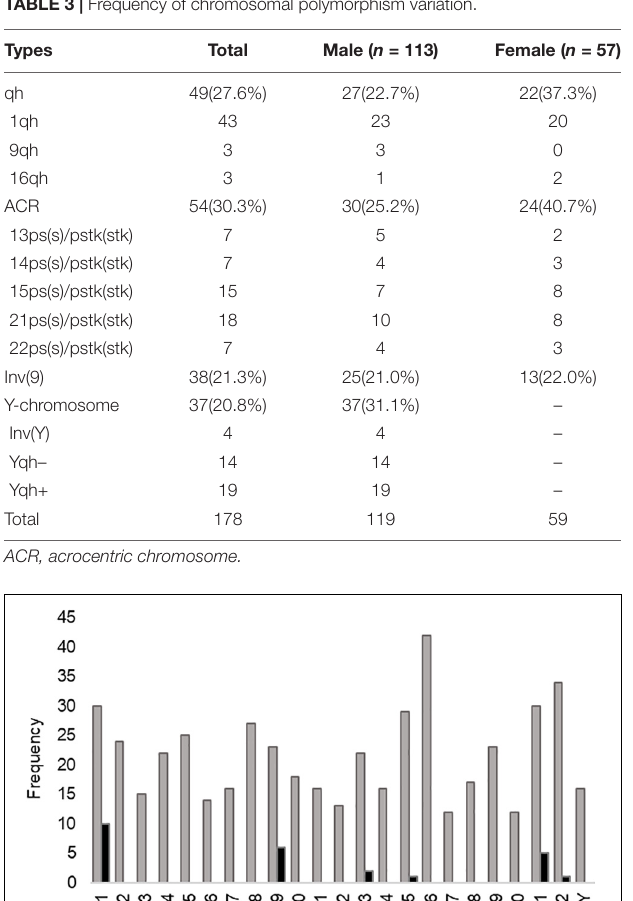
TABLE 3 | Frequency of chromosomal polymorphism variation.